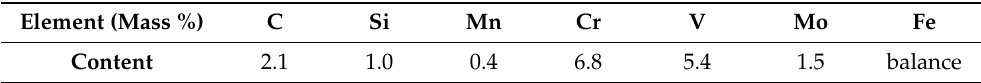
Table 1. Chemical composition of the experimental steel. Element (Mass